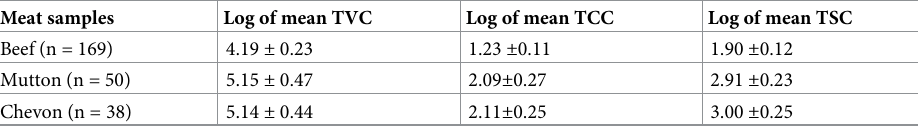
Table 2. The log of total mean ( ± SE) of TVC, TCC and TSC of different meat